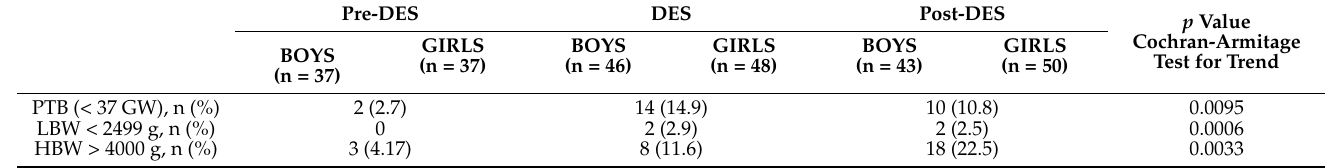
Table 3. Characteristics of G1 boys and girls in function of their DES exposure status.